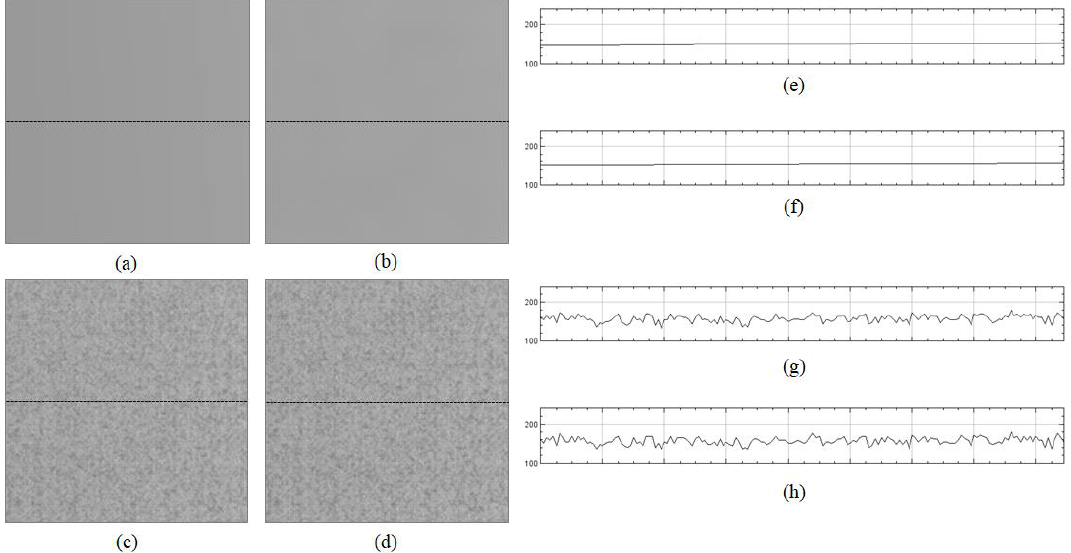
Figure 11. Flat-field distortion model estimated by two previous methods and the proposed method: ( a ) distortion model estimated by CIDRE method; ( b ) distortion model estimated by BaSiC method; ( c ) distortion model estimated by the proposed method; ( d ) ground-truth model; ( e ) intensity profile on dotted line of ( a ), ( f ) intensity profile on dotted line of ( b ), ( g ) intensity profile on dotted line of ( c ) and ( h ) intensity profile on dotted line of ( d ).